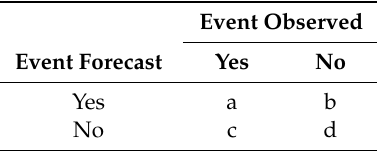
Table 2. Contingency table. The counts a, b, c, and d are the total number of hits, false alarms, misses, and correct